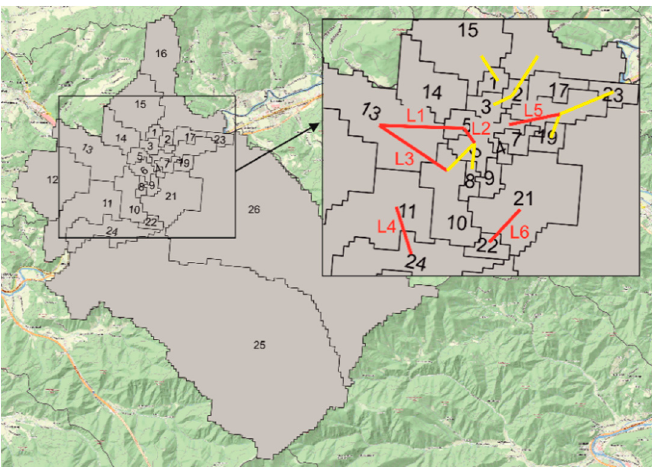
Figure 12. Cell division of the city of Leoben and detailed view with geographical location of the identified overloaded lines - in red: most stressed lines.